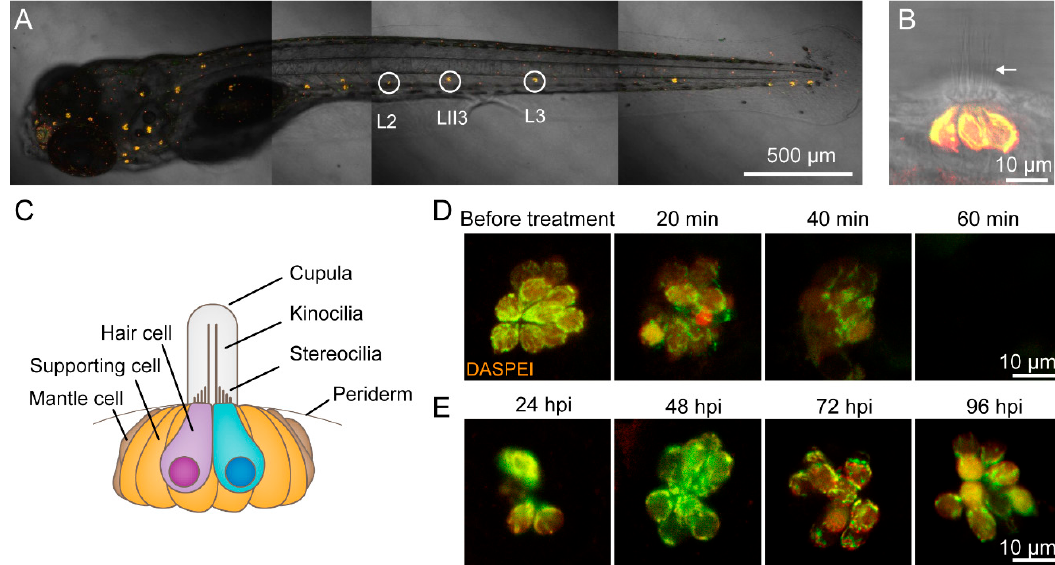
Figure 1. CuSO 4 damages hair cells in the lateral line of zebrafish. ( A ) Lateral line hair cells in a 6 days postfertilization (dpf) wild-type AB zebrafish larva is labeled with 0.05% DASPEI. L2, LII3, and L3 neuromasts are marked with circles. Scale bar represents 500 µ m. ( B ) The lateral view of a neuromast shows sensory hair cells in the center labeled with DASPEI and a bundle of kinocilia (arrow) extending out of the periderm. Scale bar represents 10 μ m. ( C ) A cartoon illustrates the structure of the neuromast. ( D ) Time lapse imaging shows that when immersed in 5 μ M CuSO 4 solution, hair cells were gradually injured and damaged within 60 min. Scale bar represents 10 μ m. ( E ) DASPEI staining displays that hair cells regenerate completely within 96 h postinjury (hpi). Scale bar represents 10 μ m.